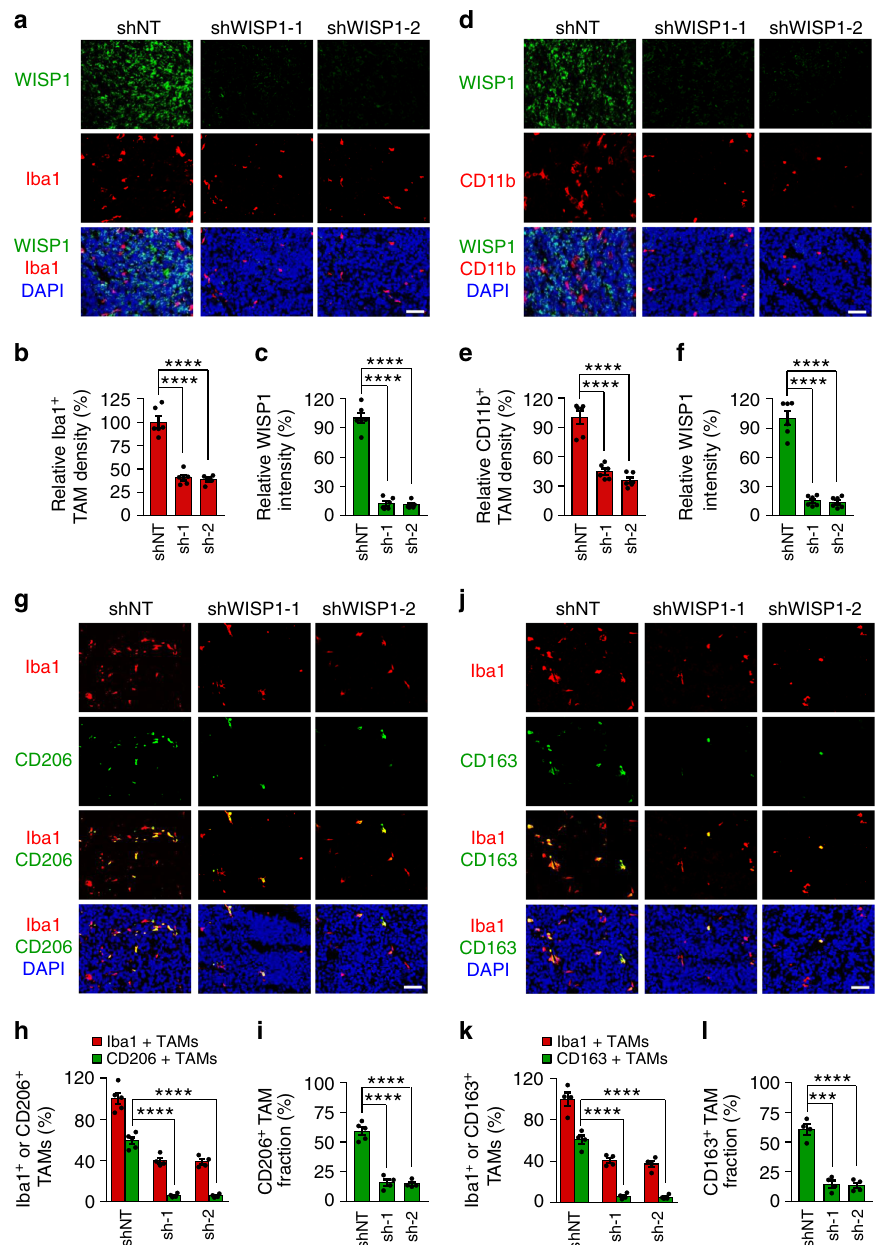
Fig. 7 Disrupting WISP1 in GSCs reduced TAM density in GBM tumors. a Immuno fl uorescent staining of WISP1 (green) and the TAM marker Iba1 (red) in GBM xenografts derived from T4121 GSCs expressing shWISP1 or shNT control. Scale Bar, 50 μ M. b , c Quantitation of Iba1 + TAM density ( b ) or WISP1 intensity ( c ) in xenografts derived from T4121 GSCs expressing shWISP1 or shNT. n = 6 (shNT or shWISP1-1) or 5 (shWISP1-2) biological independent tumor tissues. Data are shown as means± s.e.m. **** p <0.0001, two-tailed unpaired t -test. d Immuno fl uorescent staining of WISP1 (green) and the TAM marker CD11b (red) in xenografts derived from T4121 GSCs expressing shNT or shWISP1. Scale Bar, 50 μ M. e , f Quantitation of CD11b + TAM density ( e ) or WISP1 intensity ( f ) in xenografts derived from T4121 GSCs expressing shNT or shWISP1. n = 6 biological independent tumor tissues. Data are shown as means ± s.e.m. **** p <0.0001, two-tailed unpaired t -test. g Immuno fl uorescent staining of the M2 TAM Marker CD206 (green) and the pan-macrophage marker Iba1 (red) in GBM xenografts derived from T4121 GSCs expressing shNT control or shWISP1. Scale Bar, 50 μ M. h , i Quantitation of CD206 + TAM (M2) density ( h ) and the fraction of M2 TAMs ( i ) in xenografts derived from T4121 GSCs expressing shNT or shWISP1. n = 5 (shNT) or 4 (shWISP1-1 or shWISP1-2) biological independent tumor samples. The M2 TAM fraction was determined by the percentage of M2 TAMs within TAMs in shNT or shWISP1 xenografts, respectively. Data are represented as means ± s.e.m. **** p <0.0001, two-tailed unpaired t -test. j Immuno fl uorescent staining of the M2 TAM Marker CD163 (green) and the pan-macrophage marker Iba1 (red) in xenografts derived from T4121 GSCs expressing shNT or shWISP1. Scale Bar, 50 μ M. k , l Quantitation of CD163 + TAM (M2) density ( k ) and the fraction of M2 TAMs ( l ) in xenografts derived from T4121 GSCs expressing shNT or shWISP1. n = 4 biological independent tumor samples. Data are represented as means± s.e.m. *** p = 0.001, **** p <0.0001, two-tailed unpaired t -test. Xenografts were collected from mice when neurological signs occur after GSC transplantation. Source data are provided as a Source data fi